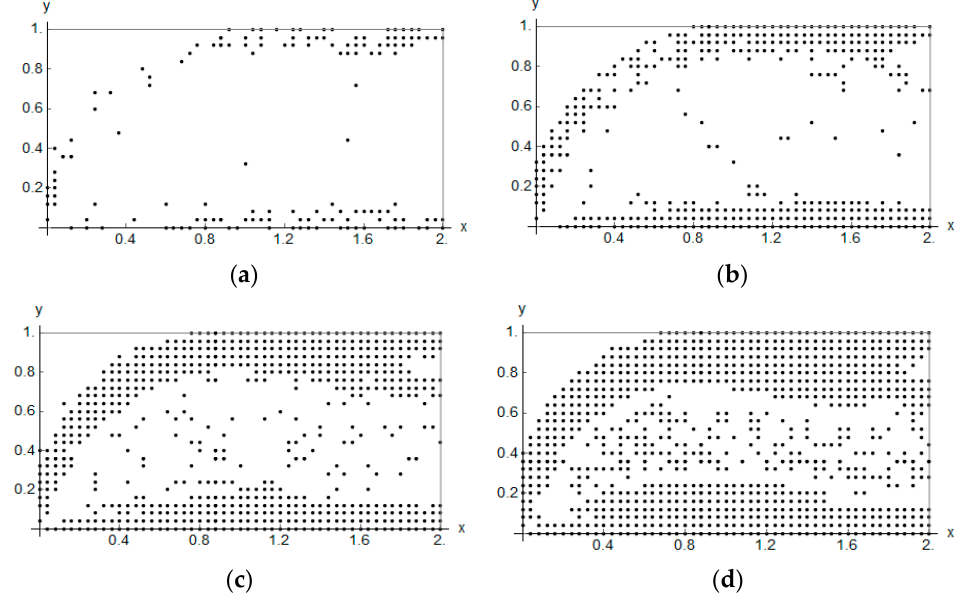
Figure 16. Positions of the isotropic RVEs approximating the IMD results (Figures 2 and 3) with an error (Equation (28)) less than: ( a ) 0.0001; ( b ) 0.001; ( c ) 0.01; and ( d ) 0.1.